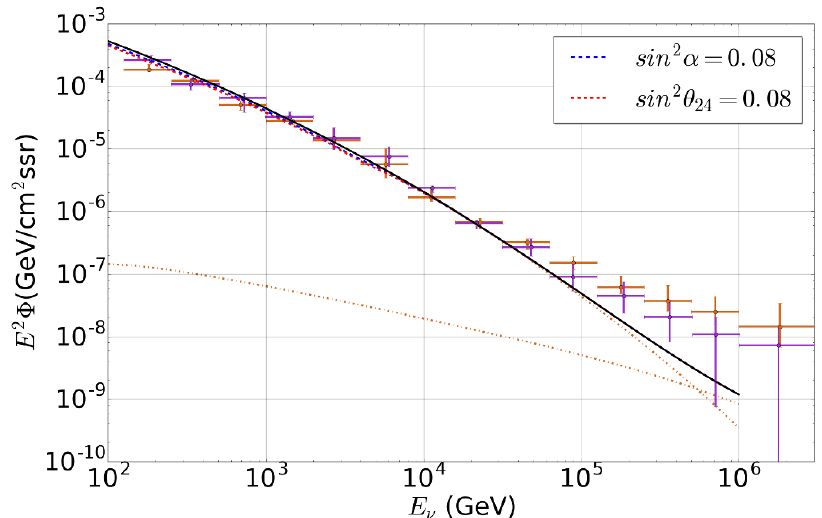
Figure 3 . Zenith-angle (86 (cid:14) {180 (cid:14) ) averaged atmospheric muon neutrino and antineutrino (cid:13)ux data [61] and models [51]. The total (cid:13)ux is composed of conventional and prompt components (orange dot-dashed lines) and shown without (cid:23) s mixing (black continuous line) and with (cid:23) s mixing (blue-dashed line for mass mixing and red-dashed line for (cid:13)avor-mixing). from the tau leptons, created by the (cid:23) N charge-current (CC) interactions. The tau leptons (cid:28) decay into muons with branching ratio (cid:15) (cid:24) 0 : 18 and the corresponding event is recorded as (cid:23) CC . The (cid:23) (cid:13)ux at the detector equals (cid:30) (cid:25) (cid:30) 0 P , since, again, (cid:30) 0 (cid:29) (cid:30) 0 and P (cid:28) 1. (cid:28) (cid:28) (cid:22)(cid:28) e(cid:28) (cid:22) (cid:22) (cid:22) e To be detected as a (cid:23) event in the same muon energy bin the (cid:23) energy needs to be (cid:25) 2 : 5 (cid:22) (cid:28) times higher than the (cid:23) (cid:22)